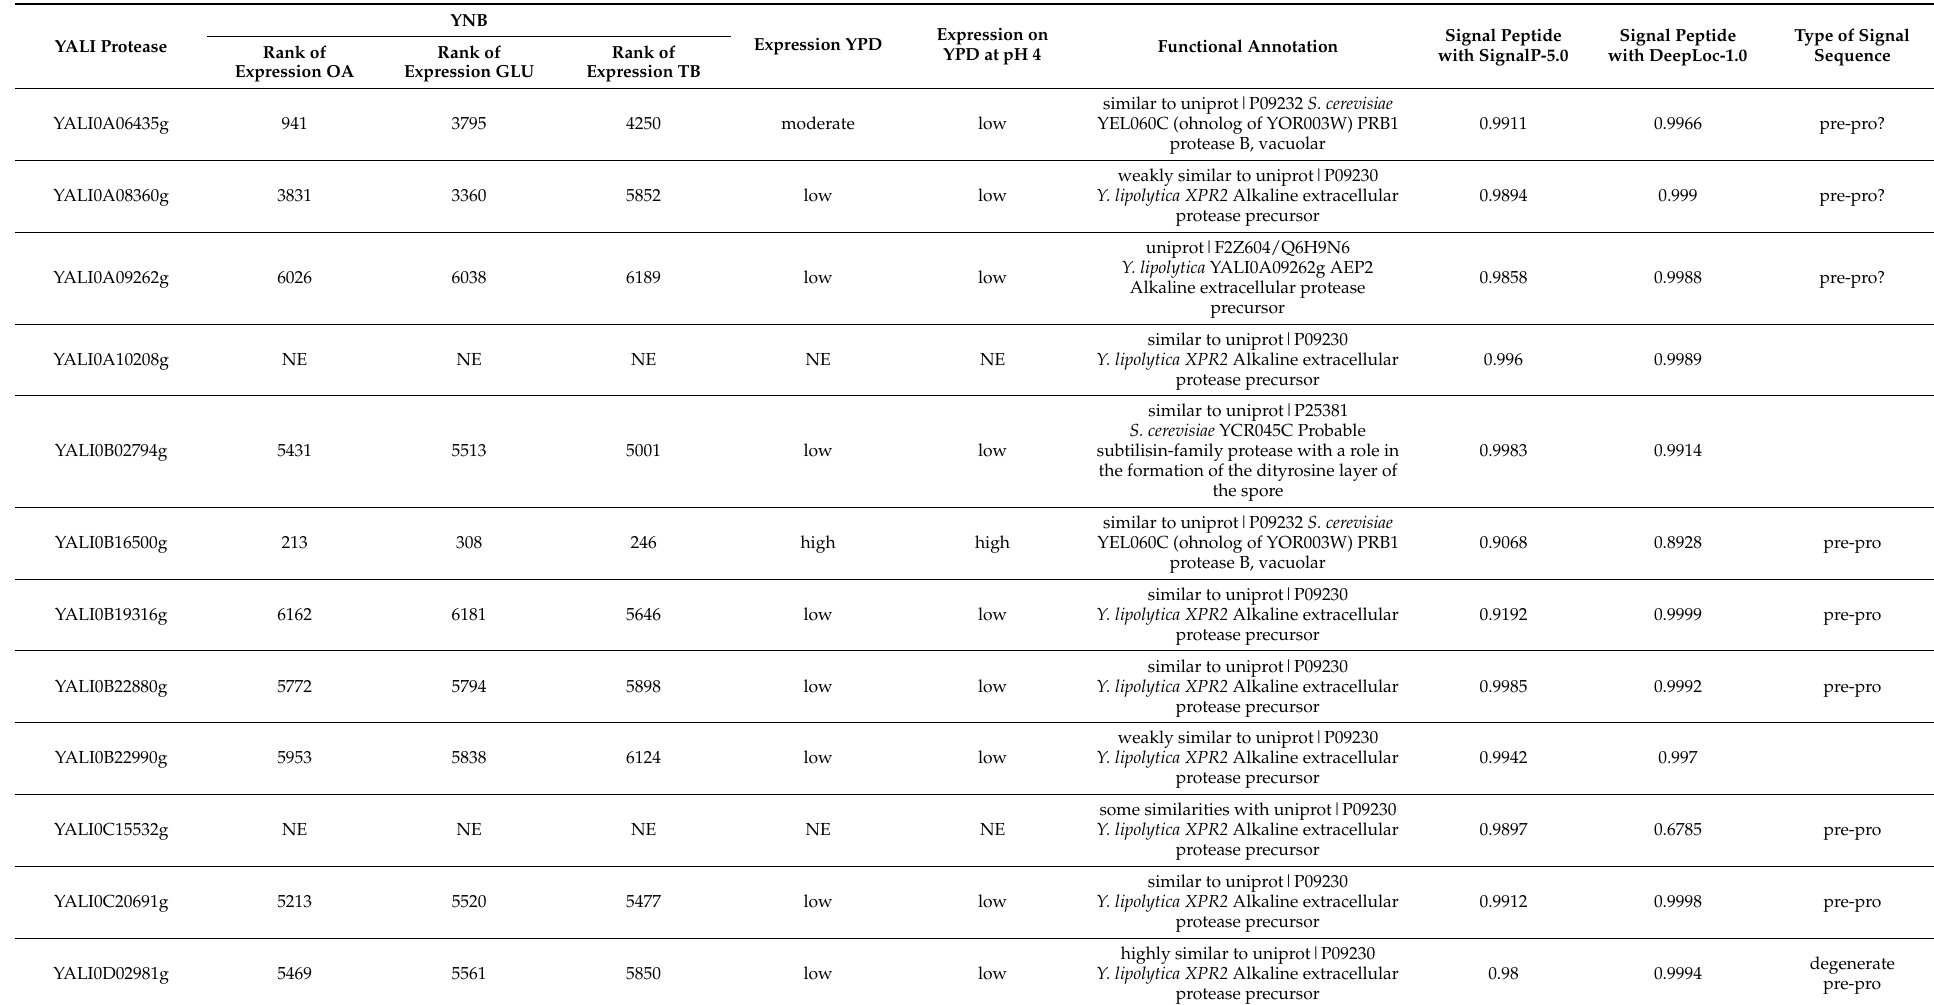
Table 2. Predictable expression of the alkaline proteases of Y. lipolytica in various culture conditions and prediction of putative signal